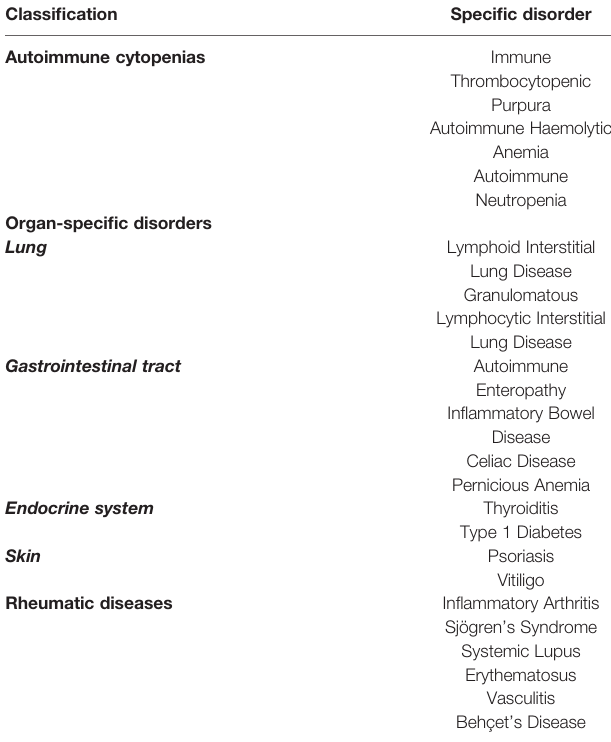
TABLE 1 | Autoimmune and autoin fl ammatory conditions reported in